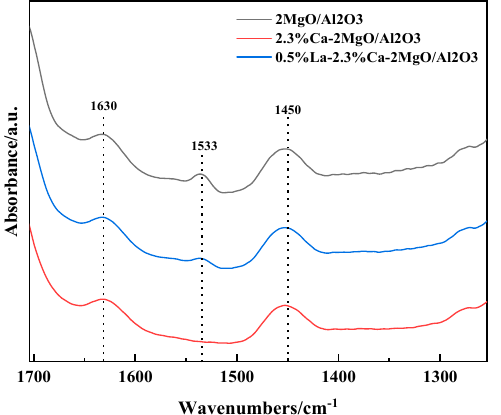
Figure 6. Py ‐ IR spectra of composite oxides. Figure 6. Py-IR spectra of composite